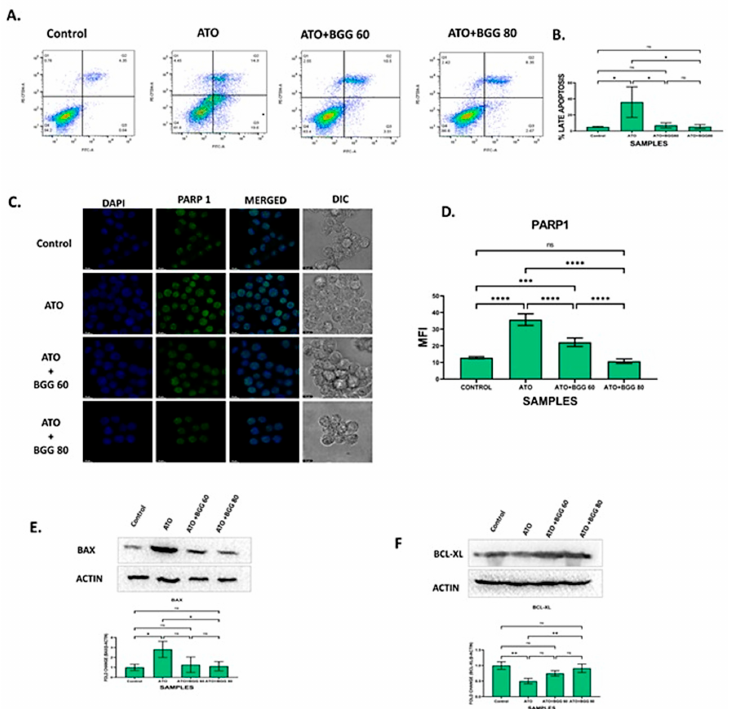
Figure 4. BGG attenuates the ATO-induced apoptosis in RAW 264.7. ( A ) BGG reversed the ATO- induced early and late apoptosis in the RAW 264.7 cells stained with Annexin V/PI, analyzed by flow cytometry. ( B ) Graph represents the percentage of late apoptosis, mean ± SD of two independent experiments. ( C ) Immunofluorescence staining represents the BGG attenuates the ATO-induced PARP1 expression, measured by confocal microscopy scale bars: 10 μ m. Western blot analysis of ( D ) graph represents the mean fluorescence intensity of PARP1 ( E ) BAX ( F ) BCL-XL. Results are mentioned as mean ± SD (* p ≤ 0.05, ** p < 0.01, *** p < 0.001, and **** p < 0.0001, ns = non-significant) ( n = 3 independent